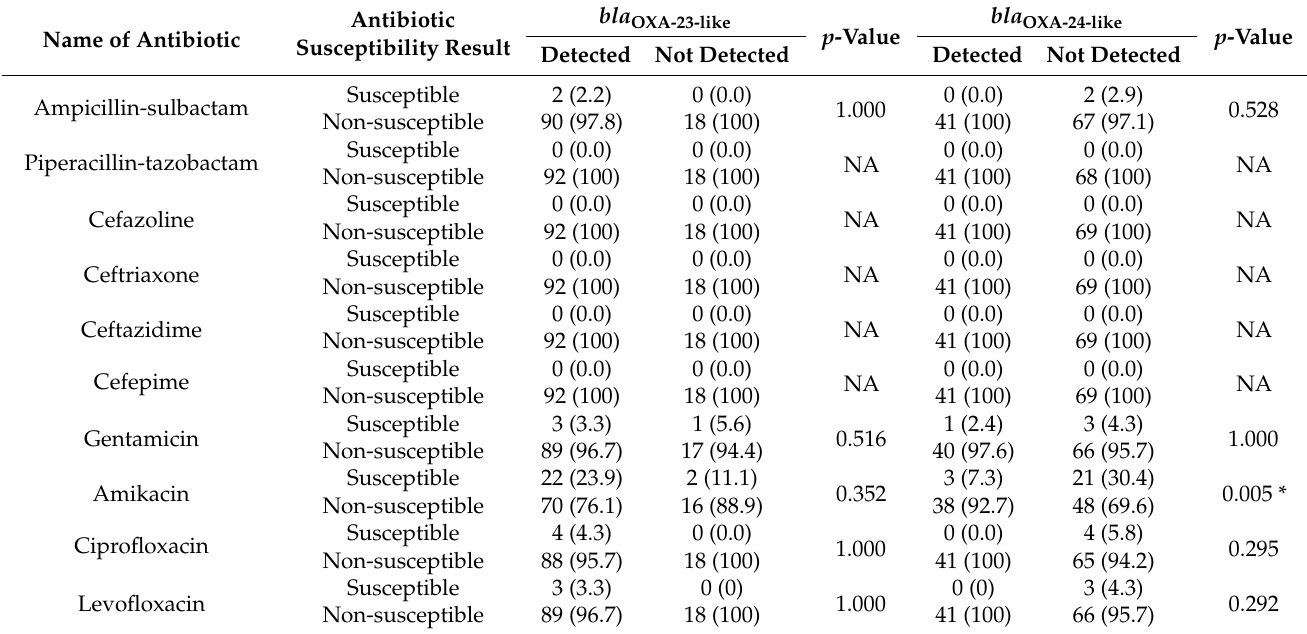
Table 4. Association between the presence of bla OXA-23-like and bla OXA-24-like genes with antibiotic sensitivity